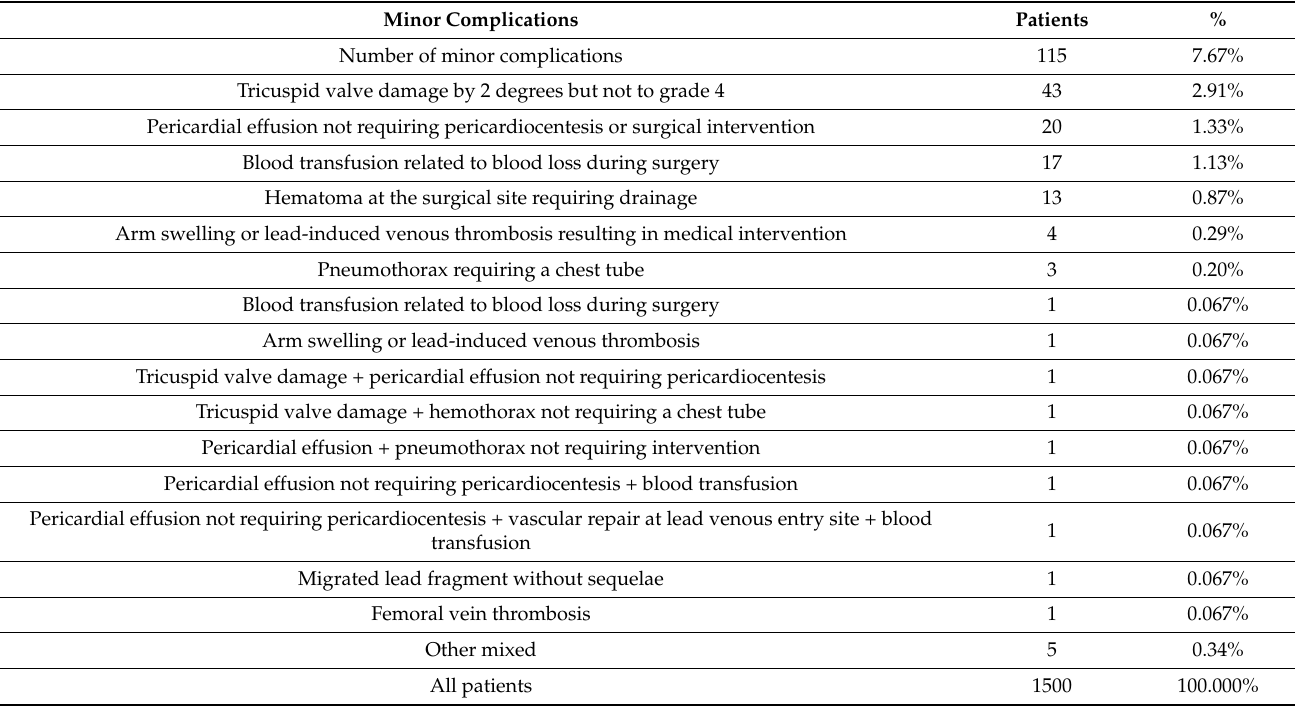
Table 3. Analysis of minor complications.